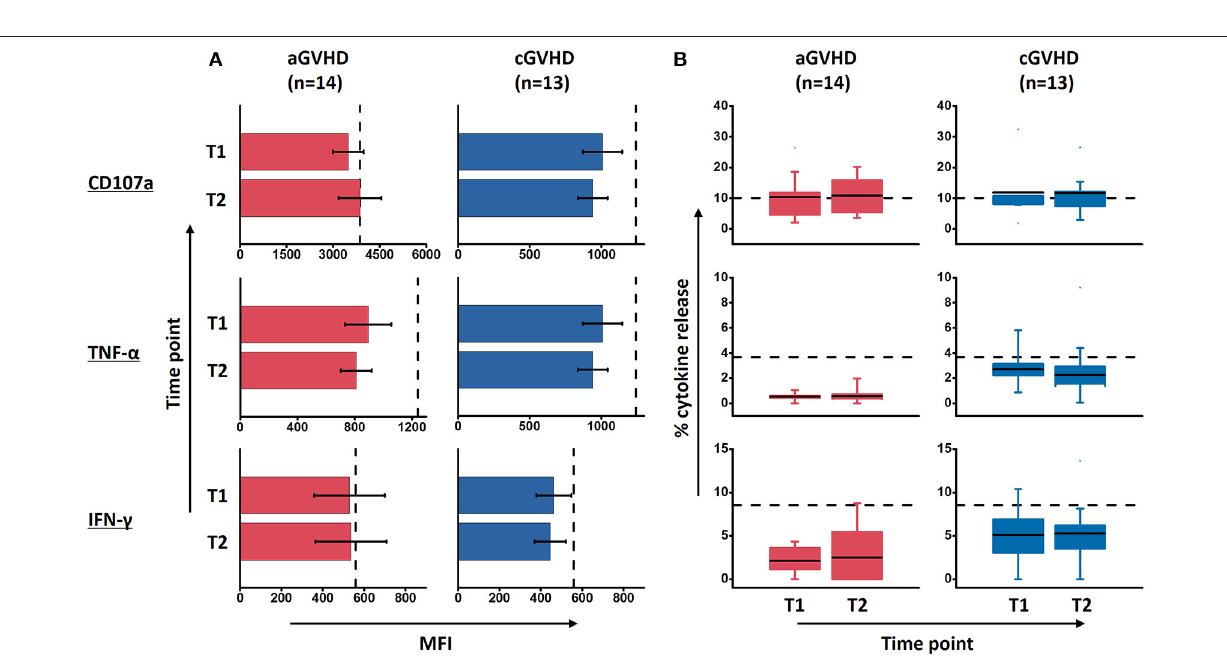
FIGURE 7 | Effect of ECP on the quality and quantity of NK cell function upon K562 stimulation. ECP therapy has no negative effect on the quality of NK cell function in terms of MFI of marker expression (A) as well as the quantity of CD107 expression and the cytokine release by NK cells (B) . Fourteen patients with aGVHD, excluding patient #5 and #8 due to the limited cell number of samples, and 13 patients with cGVHD, excluding patient #17, #18, #21, #22, and #25 due to the limited cell number of samples, were analyzed. The dashed lines represent the mean value of 10 healthy donor controls.